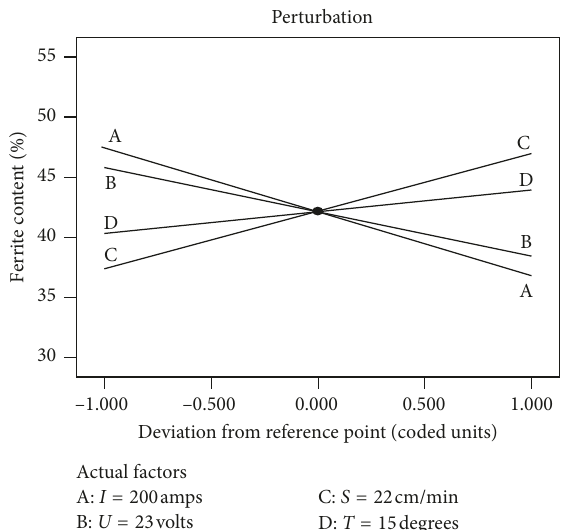
Figure 3: Perturbation plot showing the effect of all factors on the ferrite